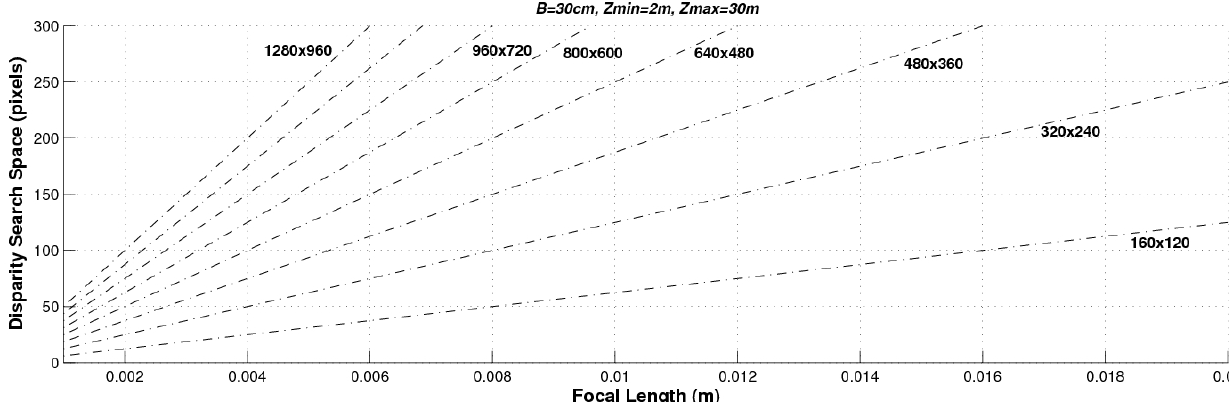
Figure 9. Size of the disparity search space as a function of the focal length, for different B t   . The disparity search space is computed image sizes, with a baseline of 400 mm x from 2 m to 30